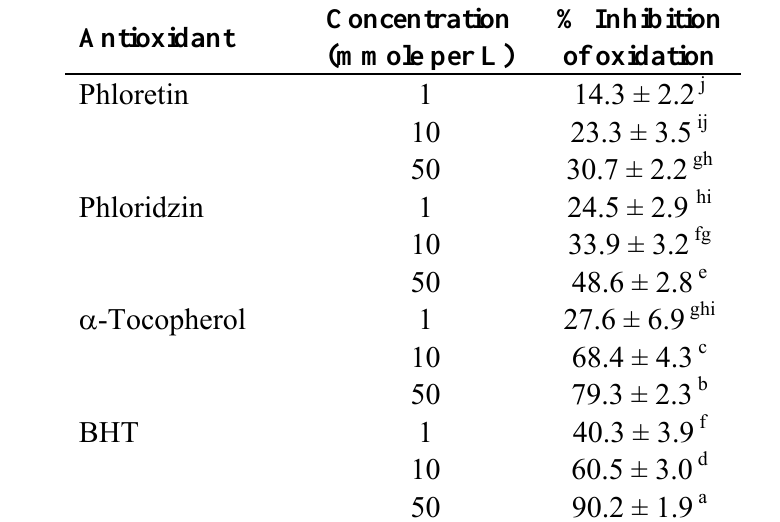
Table 2. The effect of phloretin and phloridzin on the heat-induced oxidation of fish oil.